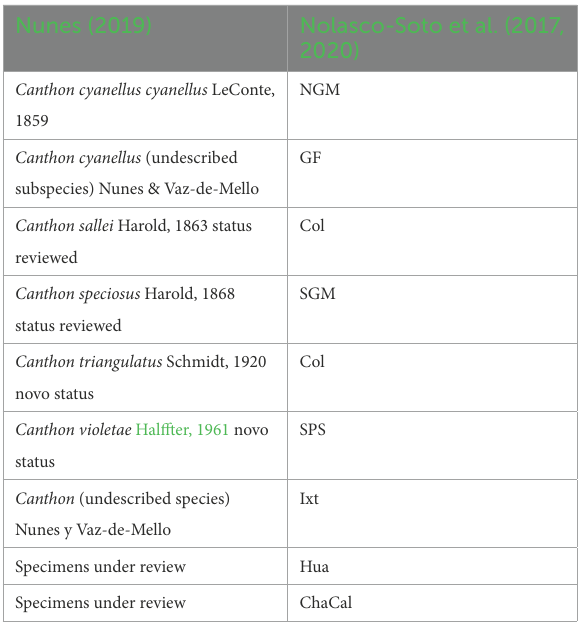
TABLE 2 Taxonomic division of Canthon cyanellus carried out by Nunes (2019) compared to the clades inferred by Nolasco-Soto et al.